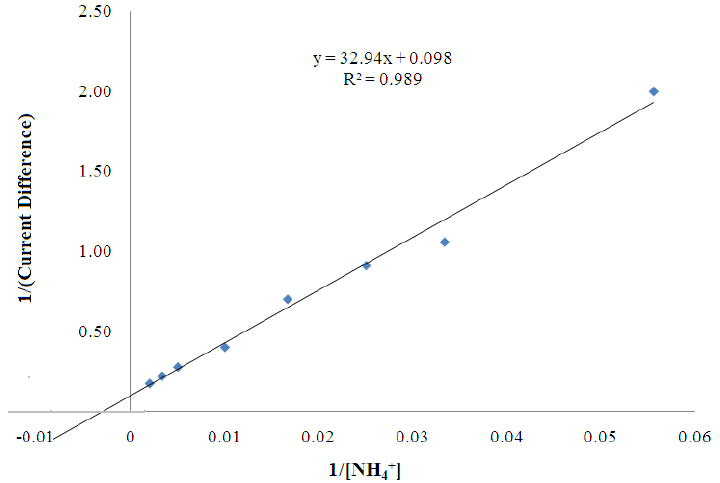
Figure 11. Lineweaver-Burk plots of the reagentless